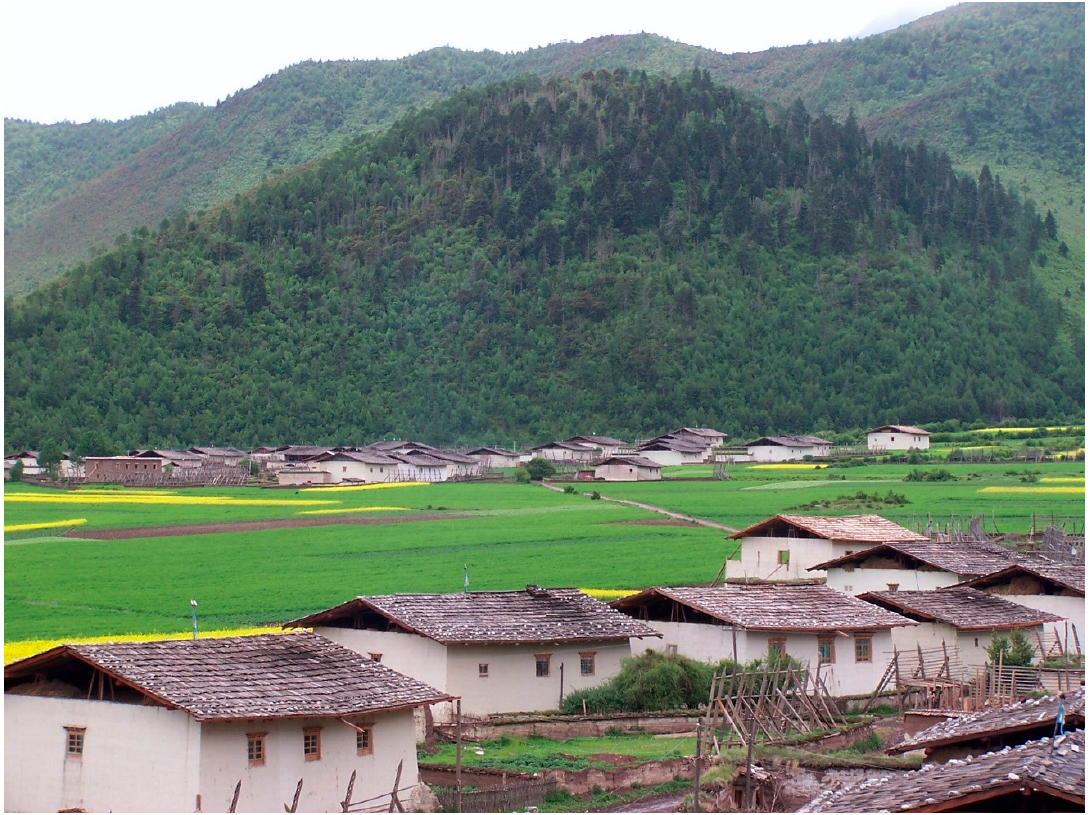
Figure 3. Hamugu village with Mount Chuji in the background. The recently restored sacred forest is visible on Chuji’s slopes. (Photo by the author, 2004)